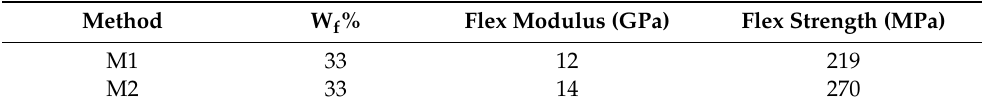
Table 5. Normalized average flexural values for the plates from each method at a unified fiber weight fraction of 33%.